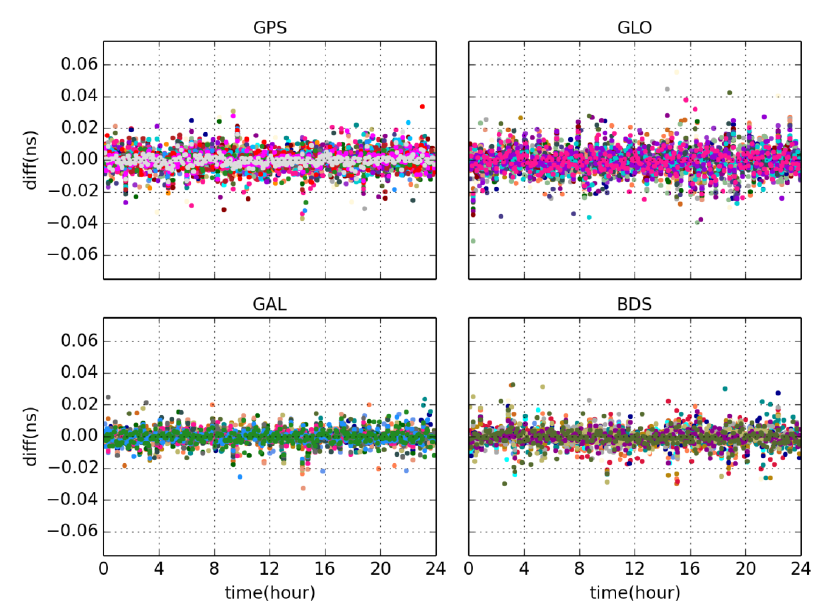
Figure 7. Differences between decentralized clock estimation (DECE) clock and undifferenced (UD) clock on DOY 251, 2018. clock on DOY 251, 2018.